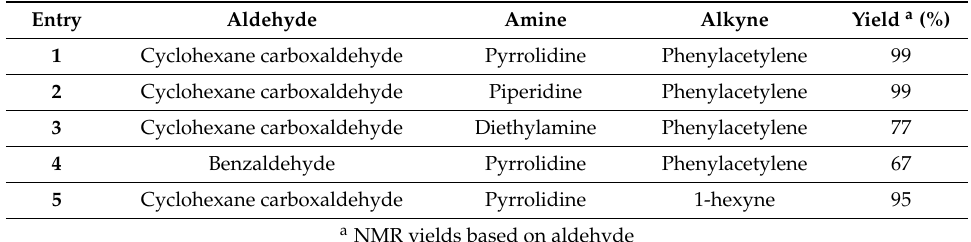
Table 5. Selected results from the A 3 coupling reaction (iPrOH, 90 ◦ C, 24 h, air atmosphere, 3 mol %